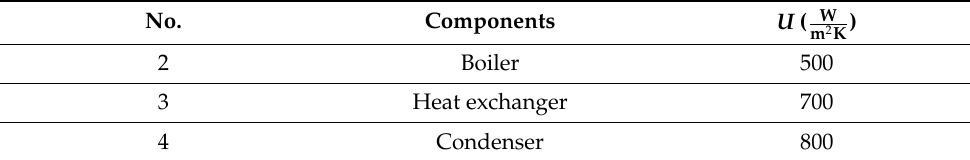
Table 8. The overall heat transfer coefficient values for